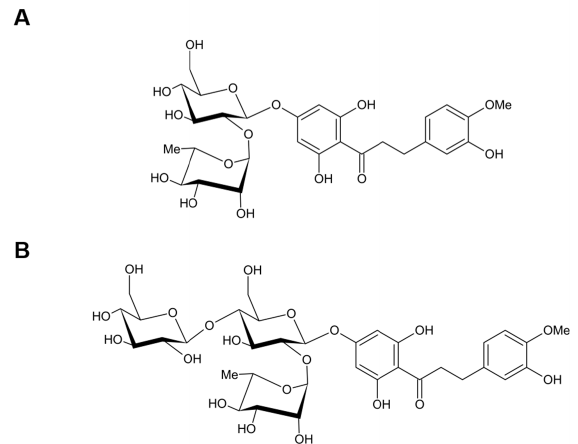
Figure 1. Structure of NHDC and GNHDC. The molecular structure of ( A ) NHDC and ( B ) GNHDC are presented. NHDC, neohesperidin dihydrochalcone; GNHDC, NHDC-O-glycoside.